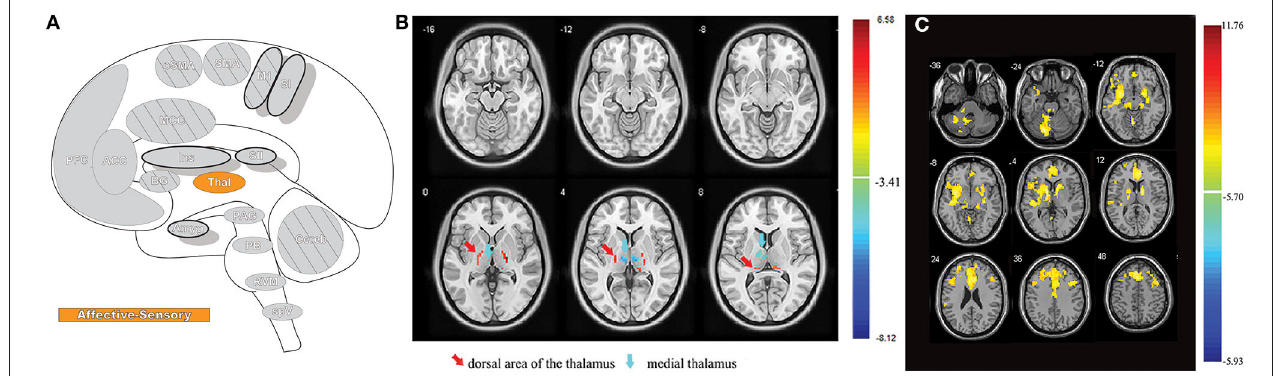
FIGURE 13 | Thalamus. (A) Brain areas active during pain: Thalamus (Thal) highlighted. (B) An examination of resting state fMRI data finds that participants with orofacial pain, experimentally induced by orthodontic separators, have significantly different patterns and intensity of spontaneous neural activity (red = increased, blue = decreased) compared to controls; differences such as these support the notion that the thalamus has a greater role in somatosensory processing than simply relaying afferent signals. Reprinted from Frontiers in Neurology, Vol 11, Y Jin, H Yang, F Zhang, J Wang, H Liu, X Yang, H Long, F Li, Q Gong, W Lai, The Medial Thalamus Plays an Important Role in the Cognitive and Emotional Modulation of Orofacial Pain: A Functional Magnetic Resonance Imaging-Based Study, p589125, Copyright (2021) Jin et al., under the Creative Commons Attribution License (CC-BY). DOI: https://doi.org/10.3389/fneur.2020.589125. (C) The same orofacial pain participants from (B) were also found to have a widespread and significant reduction (yellow areas) in resting state functional connectivity between the medial thalamus and other brain areas, emphasizing the comprehensive brain-wide interconnections of the thalamus and its engagement in pain processing. Reprinted